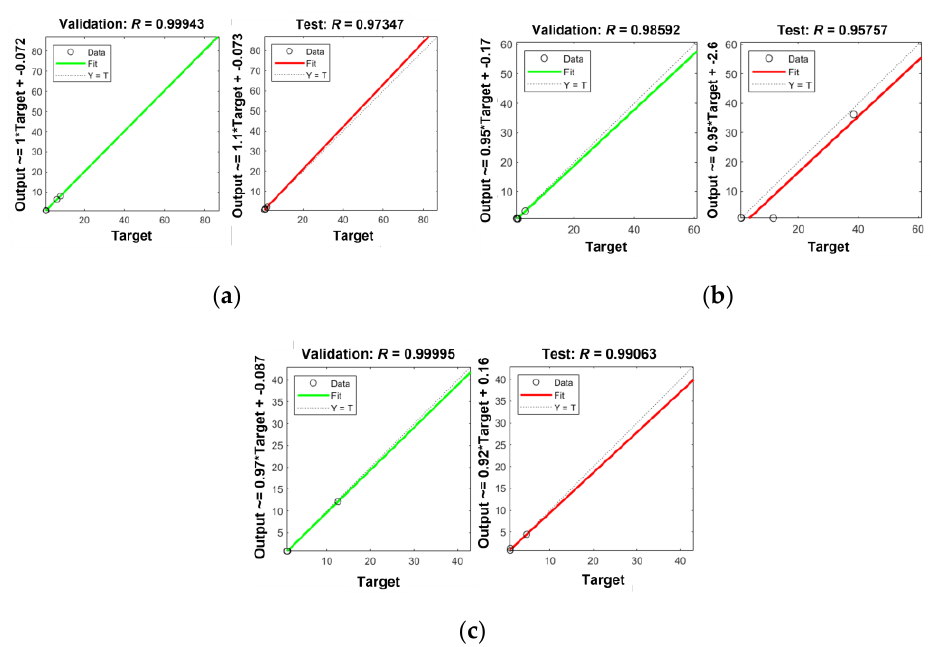
Figure A7. Correlation plots for NN-PSO simulations of MPI for ( a ) TW, ( b ) GW, and ( c ) WRS.